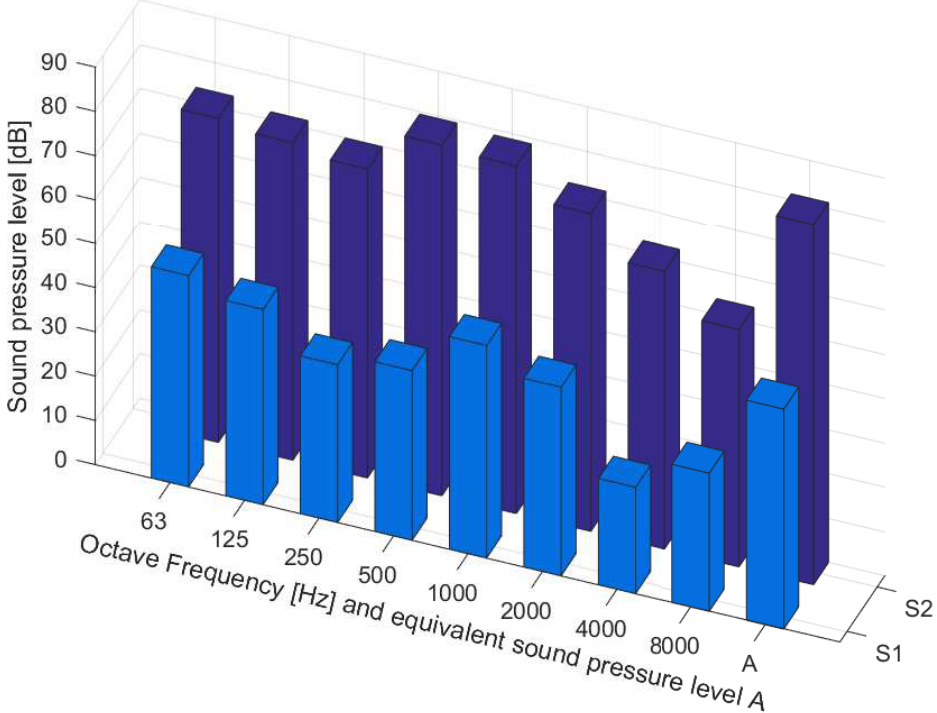
Figure 22. Sound pressure level in octave bands and equivalent sound pressure level A: dark blue—truck crossing, light blue—acoustic